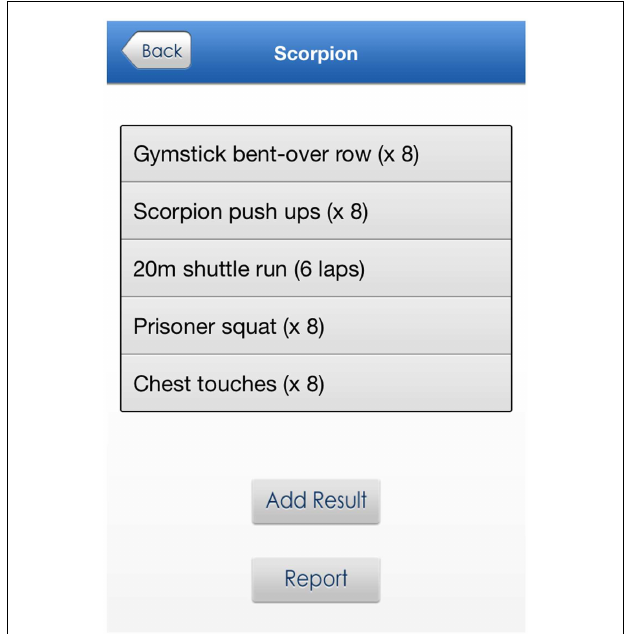
FIGURE 2 | Sample challenge workout .